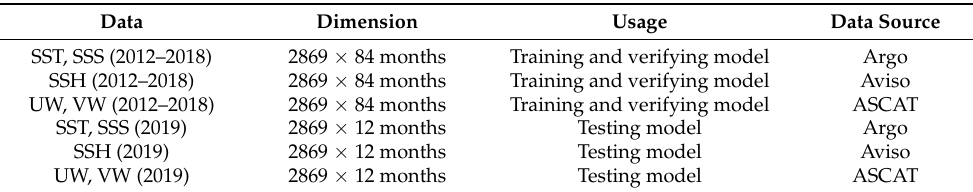
Table 1. Data summary.